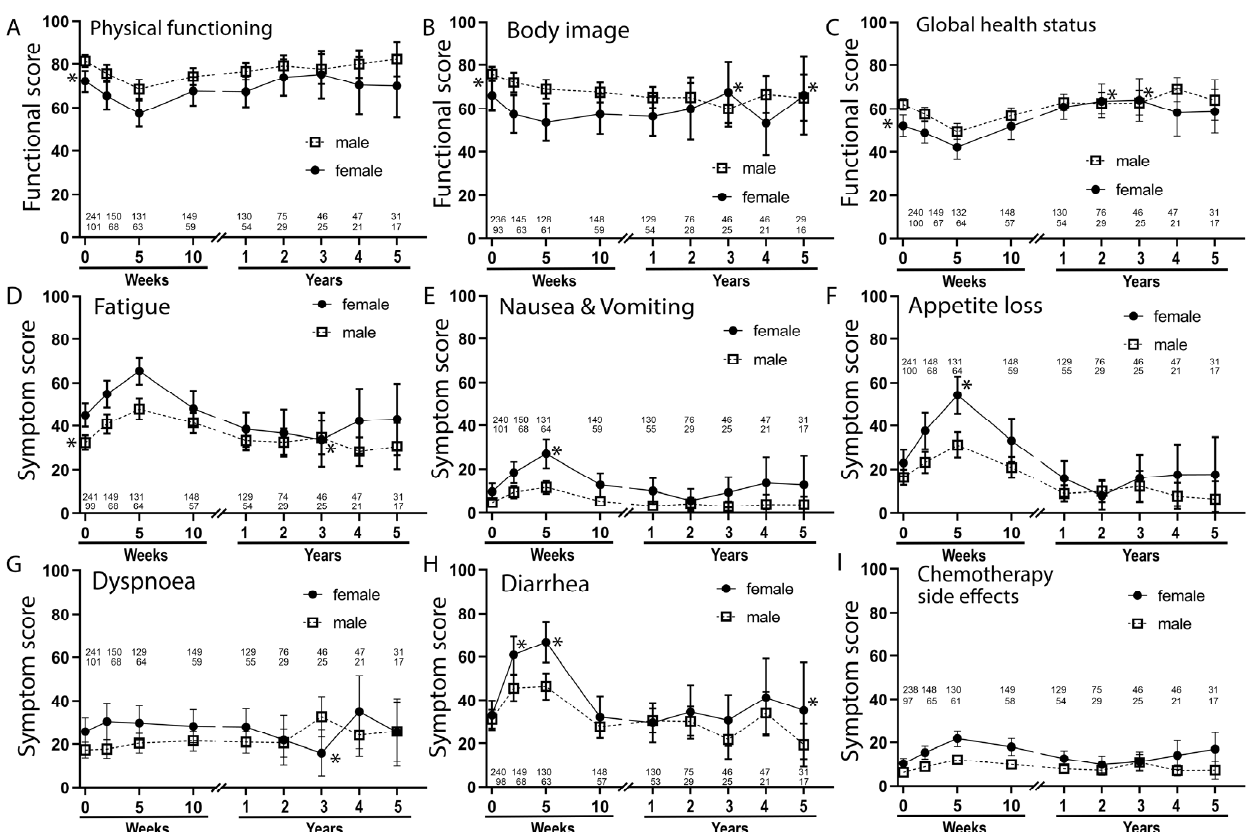
Figure 9. Quality of life by QLQ C30 and CR38 questionnaires of the quality of life cohort. Data points are baseline, during RCT (2nd and 3rd point), directly prior to surgery (4th point) and 1 to 5 years after beginning of RCT. Functional scores ( A – C ) and symptom scores ( D – I ). The scores are: ( A ) Physical functioning ( B ) Body image ( C ) Global health status ( D ) Fatigue ( E ) Nausea & Vomiting ( F ) Appetite loss ( G ) Dyspnoea ( H ) Diarrhea ( I ) Chemotherapy side effects. Asterisks to the left of the abscissa mark differences of more than 10% in the baseline, and asterisks (*) in the time data mark a change of more than 10 percentage points from the baseline. The length of the error bars corresponds to the 95% confidence interval for the mean. The number of patients who answered the questionnaires is given.